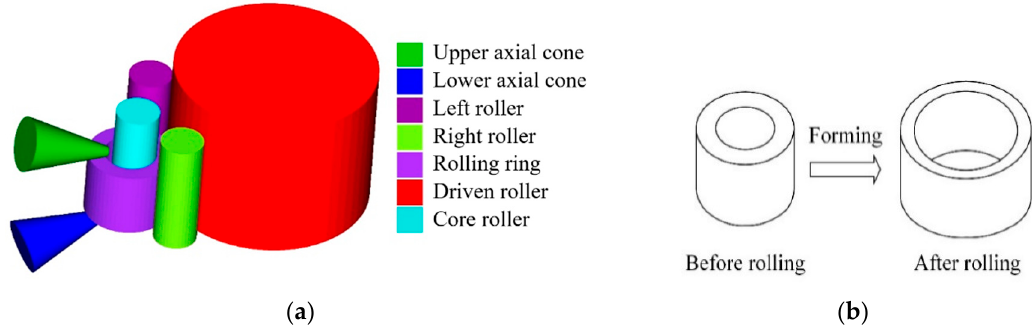
Figure 5. Simulation model and ring ‐ rolling process: ( a ) finite element model of ring ‐ rolling process; ( b ) Forming process of rolling ring.